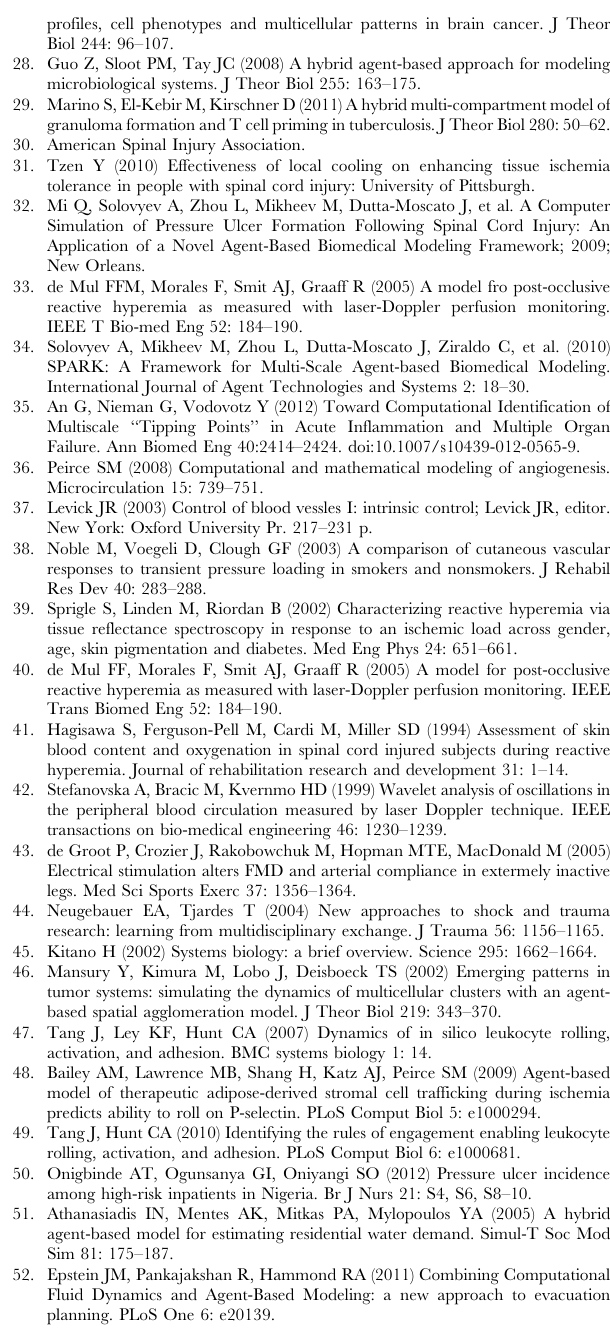
Dataset S1 Raw blood flow data of reactive hyperemia experiment for all subjects. Dataset S2 Plots of the blood flow data of reactive